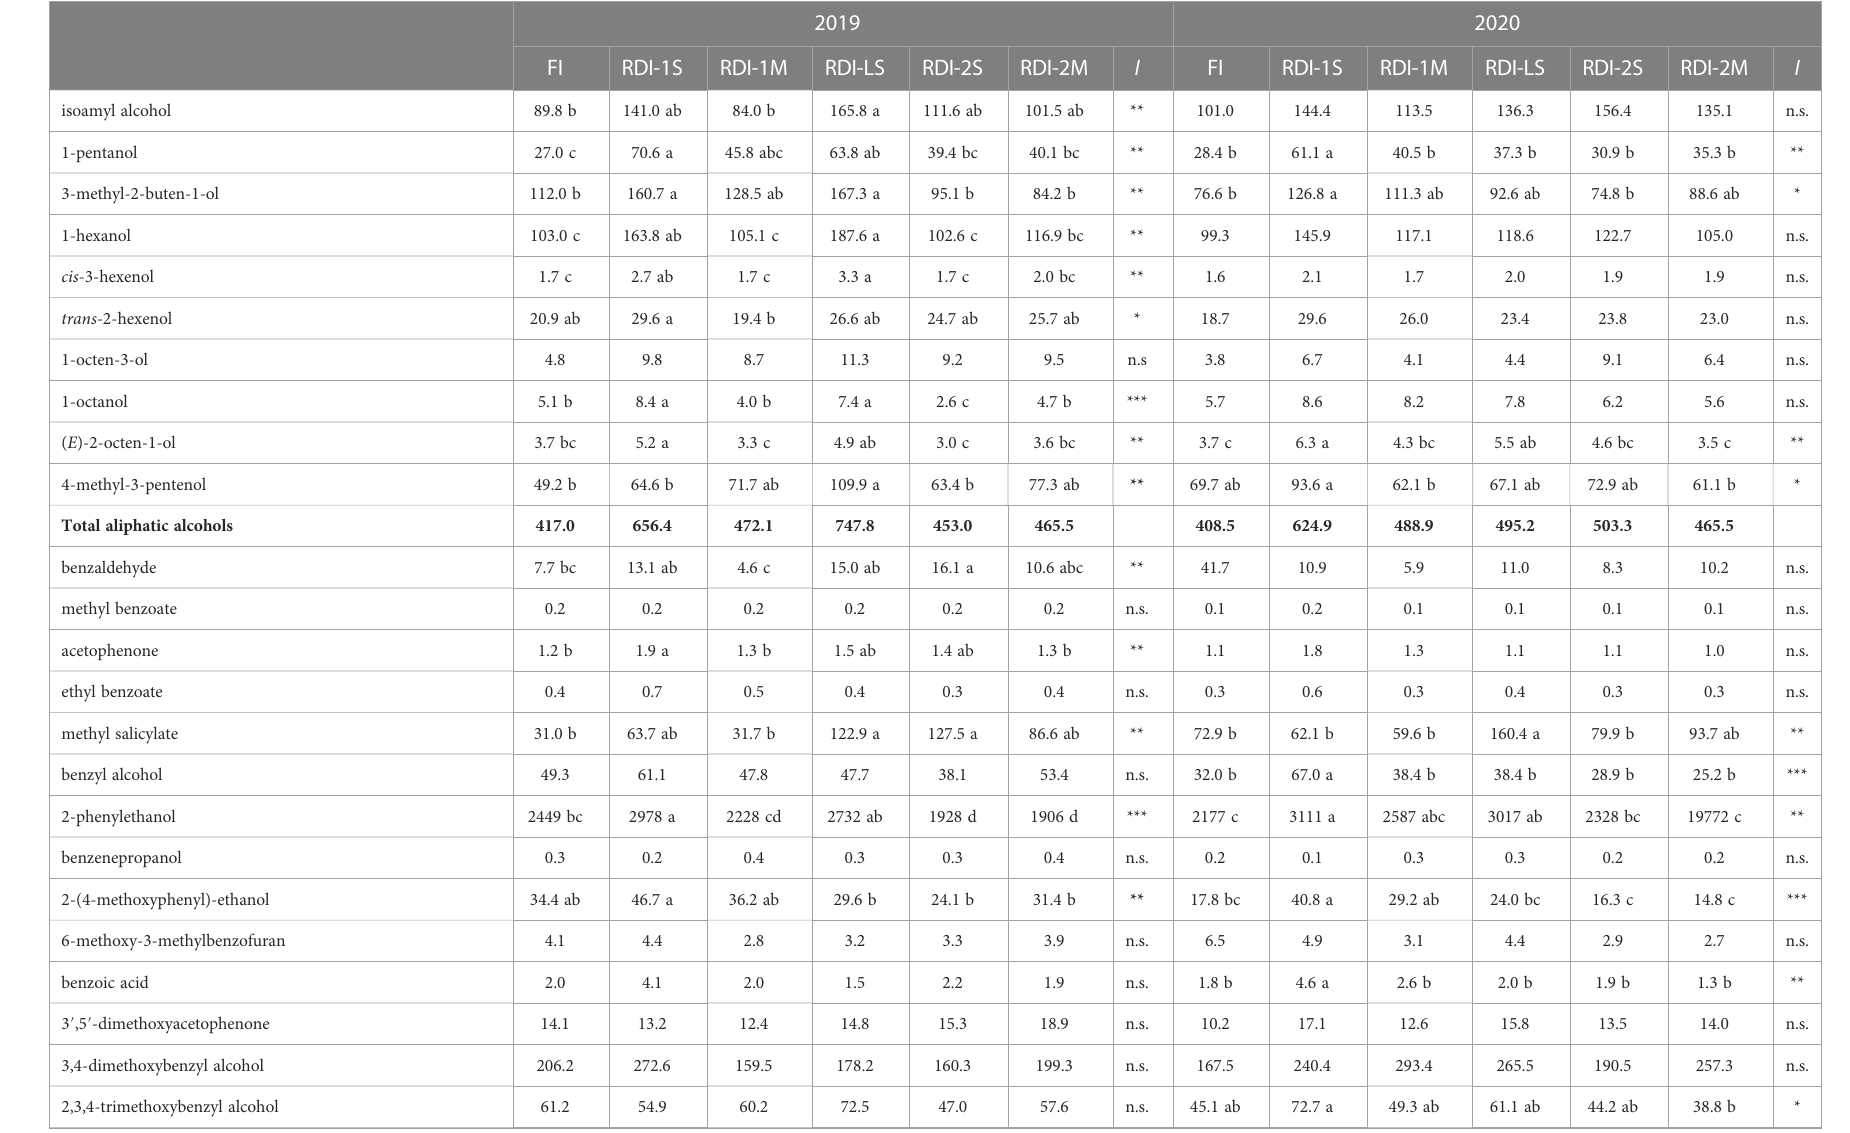
TABLE 3 Glycosylated VOCs measured at harvest in berries of Sangiovese grapevines ( Vitis vinifera L.) subjected to six irrigation regimes (FI, full irrigation from berry pea size to harvest; RDI-1S and RDI-1M, severe and moderate water de fi cit applied from berry pea size to veraison; RDI-LS, water de fi cit applied during lag-phase; RDI-2S and RDI-2M, severe and moderate water de fi cit applied from veraison to harvest) in 2019 and